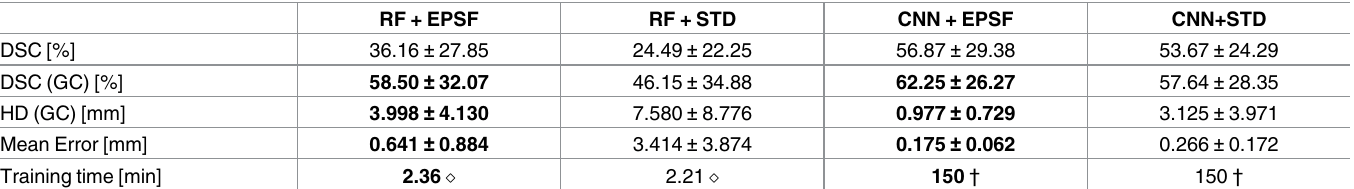
Table 2. DSC performance for different scenarios before and after Graph-cut (GC) inference. Hausdorff Distance(HD) and Mean DistanceError after GC inference. Completeresults in S1 Table. Experiments were computedon (cid:5) : Macbook Pro Intel-Core ™ i7 16GB—2, 5 GHZ & †: Intel-Core ™ i7 6700 32GB with Nvidia GTX Titan X ® .